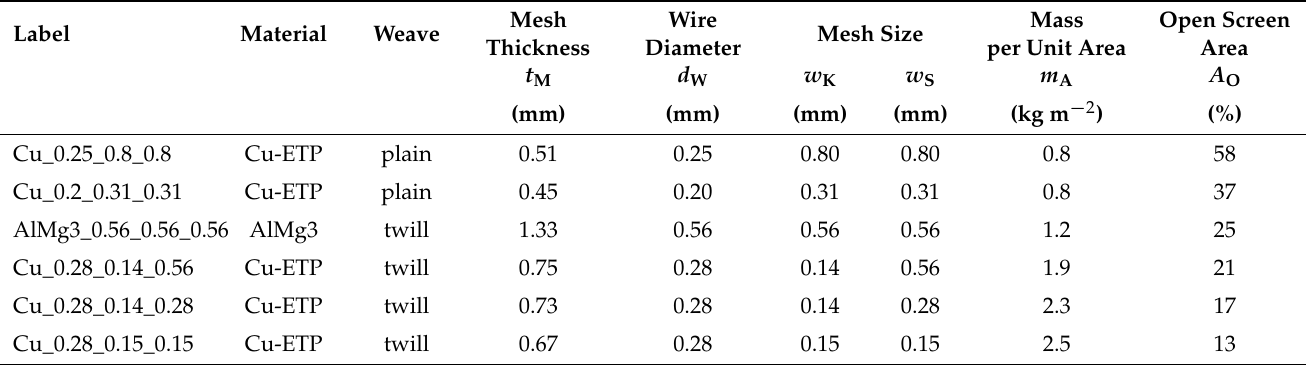
Table 2. Parameters of the investigated metal mesh according to DIN ISO 9044